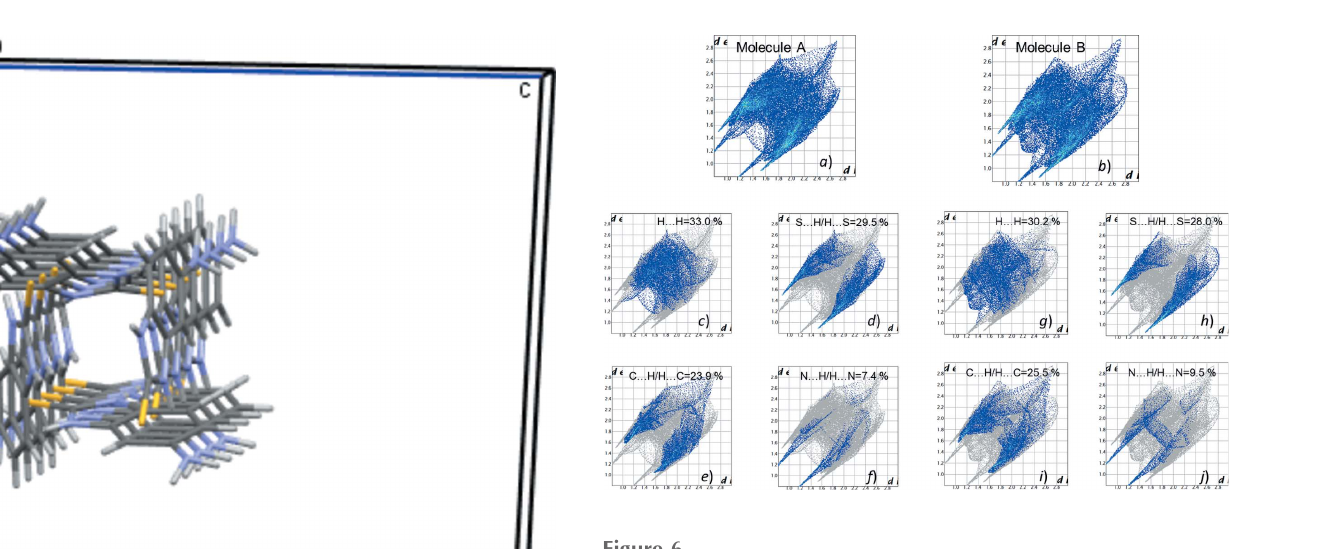
Figure 6 Two-dimensional Hirshfeld fingerprint plot of all contacts for molecules